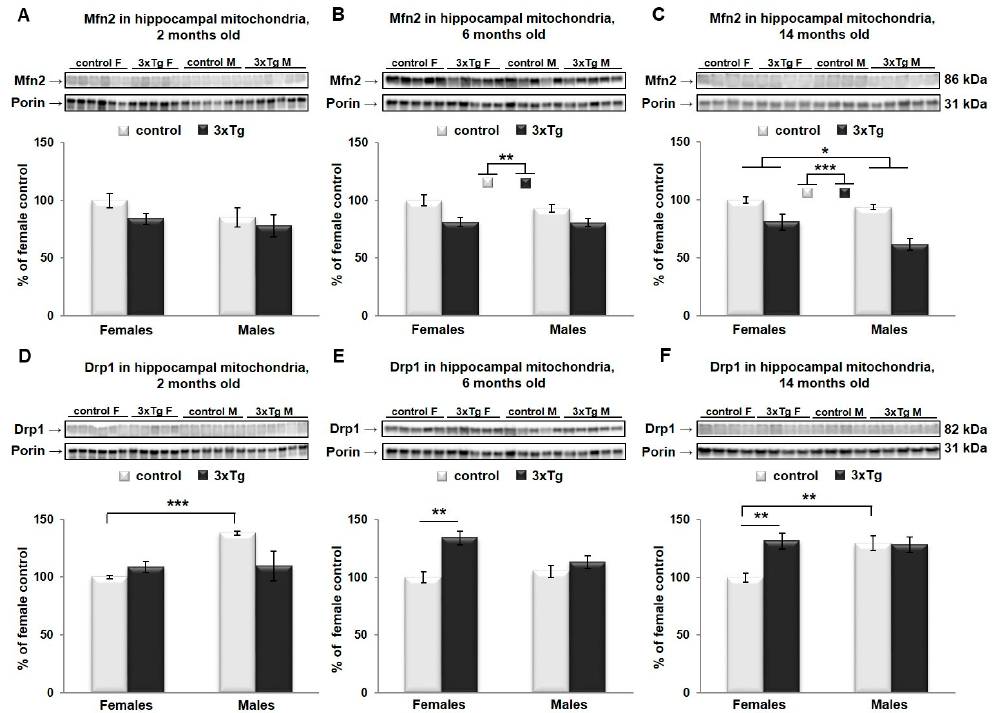
Figure 5. Mfn2 and Drp1 protein levels in hippocampal mitochondria. Representative WBs for Mfn2 ( A – C ) and Drp1 ( D – F ) and their relative quantification normalized to porin protein levels in the hippocampus of 2-, 6- and 14-month-old 3xTg female mice and their respective controls. Data were analyzed by two-way ANOVA, and results are expressed as percent change from control mean of 100% ± SEM of n = 4–6 animals per group. Mfn2 protein levels were significantly di ff erent in hippocampal mitochondria as a function of genotype in 6- and 14-month-old mice (** p < 0.01 and *** p < 0.001 respectively) and sex (* p < 0.05) in 14-month-old mice, with no significant interaction e ff ect between sex and genotype in any group. Drp1 protein levels were significantly di ff erent as a function of sex in two 2-month-old mice (* p < 0.05), and as a function of genotype in 6- and 14-month-old mice (** p < 0.01 and * p < 0.05 respectively), with a significant interaction e ff ect (* p < 0.05) between sex and genotype